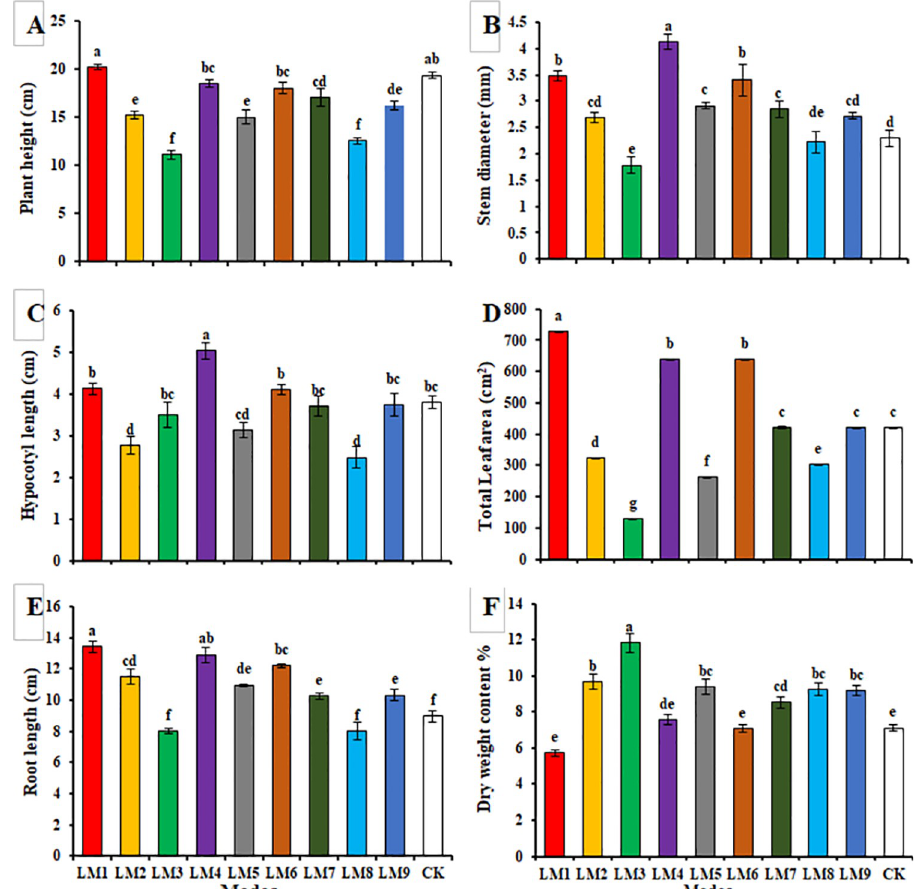
Fig 3. Effects of different lighting modes (LM) on the growth parameters of E . Sativa ; plant height (A), stem diameter (B), hypocotyl length (C), total leaf area (D), root length (E), and dry weight content (F). Values are means of four replicates ± SE. Different letters between columns indicate significant differences according to Duncan’s multiple range test at P � 0.05. LM1 = A1:B1:C1, LM2 = A1:B2:C2, LM3 = A1:B3:C3, LM4 = A2:B1:C2, LM5 = A2:B2:C3, LM6 = A2:B3:C1, LM7 = A3:B1:C3, LM8 = A3:B2:C1, LM9 = A3:B3:C1, CK = White fluorescent light.